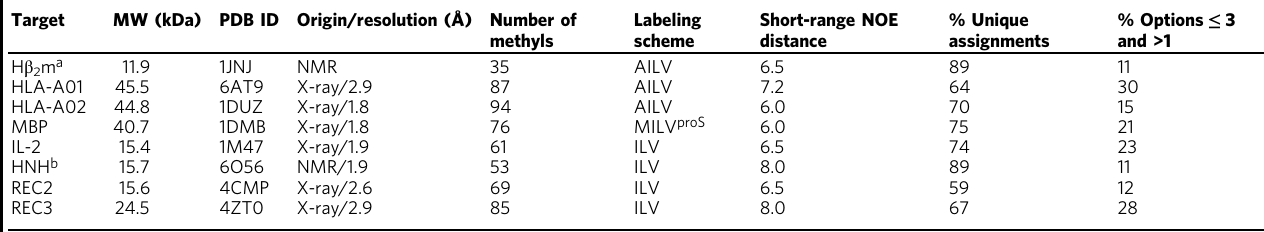
Table 1 MAUS methyl resonance assignment statistics. Target